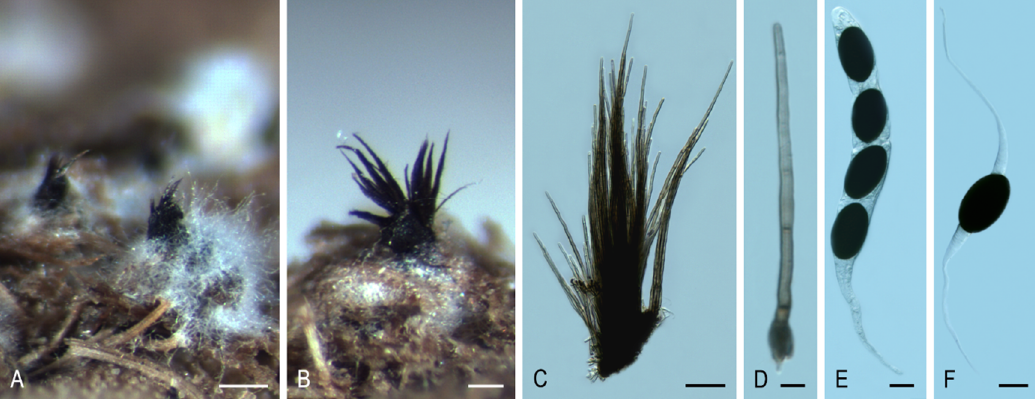
Figure 9 . Triangularia arizonensis SMH 9134.1. ( A , B ) Ascomata. ( C ) Tuft of agglutinated hairs from the neck. ( D ) Hair from the neck. ( E ) Ascus and ascospores. ( F ) Ascospores. Bars: ( A ) = 200 µm; ( B ) = 100